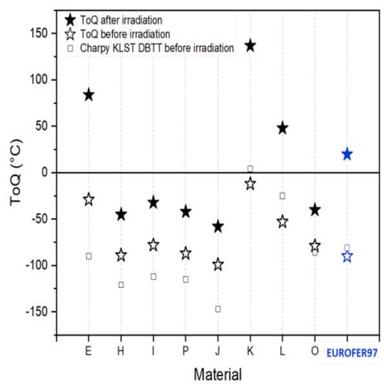
T0Q measurements by fracture toughness tests with the Master curve approach before and after irradiation at 300◦C +/− 30◦C, 2.5 dpa. Materials M and N were excluded because of the failing irradiation temperature. Data of EUROFER97 (taken from MPH) are included as reference as well as DBTT measured by Charpy tests on unirradiated KLST samples.